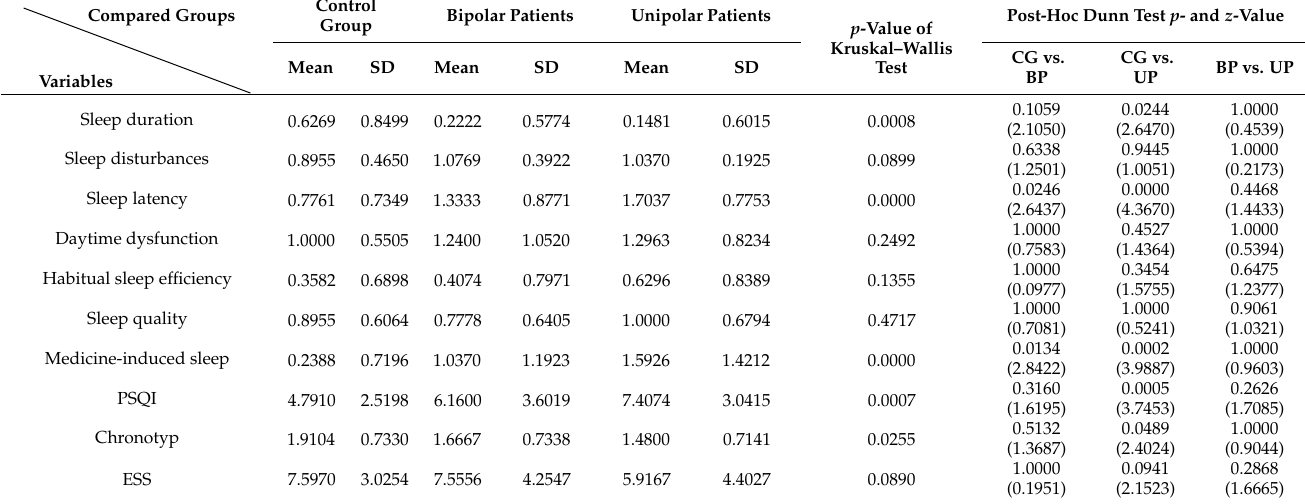
Table 3. The Pitsburgh Sleep Quality Index sleep variables differences between controls and selected groups of